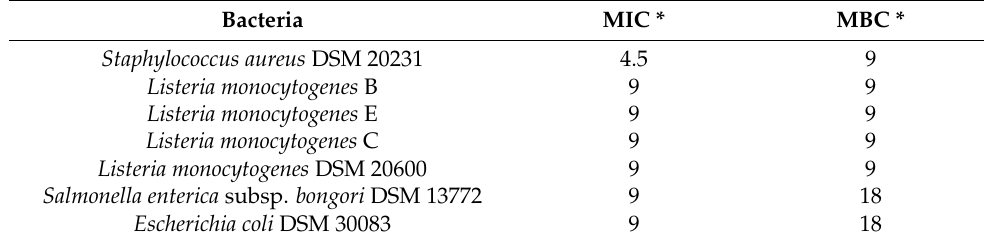
Table 2. Minimum inhibitory concentrations (MIC, mg/mL) and minimum bactericidal concen- trations (MBC, mg/mL) of the diethyl ether extracts of saffron stamens against the microorgan- isms